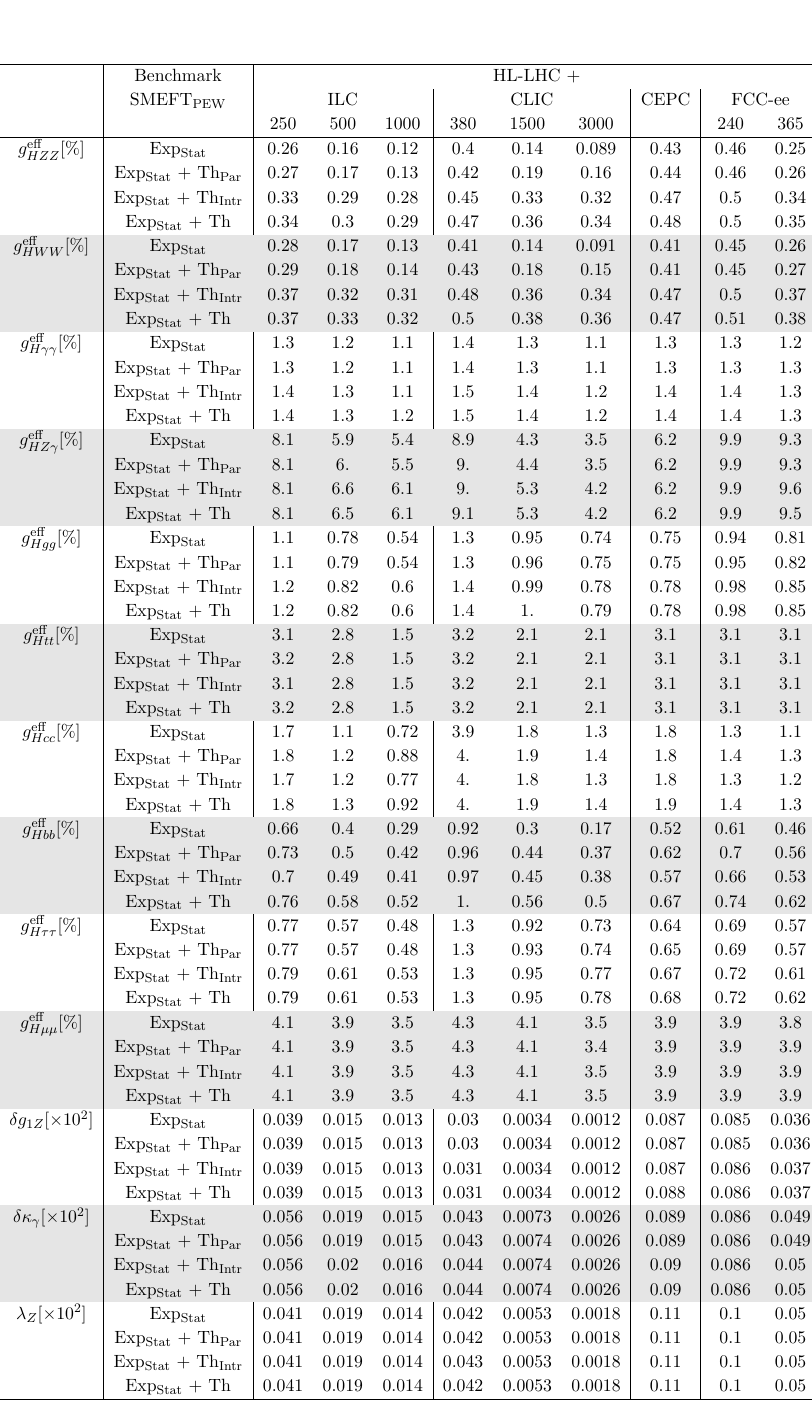
Table 11 . Comparison, within the SMEFT PEW (cid:12)t, of the sensitivity at 68% probability to devia- tions in the di(cid:11)erent e(cid:11)ective Higgs couplings and aTGC under di(cid:11)erent assumptions for the SM theory uncertainties. We compare the results obtained neglecting both intrinsic and parametric uncertainties, including each of them separately, and (cid:12)nally adding the full SM uncertainty.